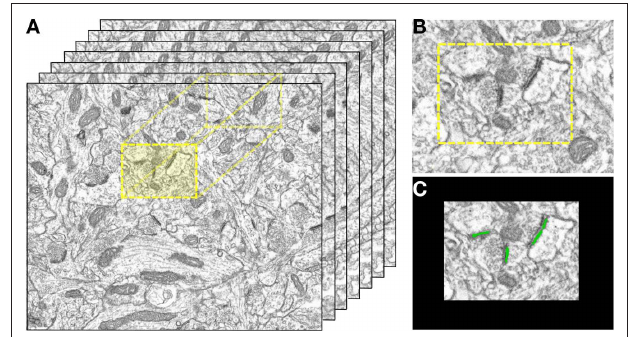
Figure 5 | (A) A region of interest (ROI) can be defined in 3D. In this example, a ROI (in yellow) has been chosen to delimit the working area. The ROI can be magnified and translated independently of the rest of the stack. (B) Higher magnification of the ROI. (C) Segmentation of three asymmetric synapses (in green) inside the ROI.